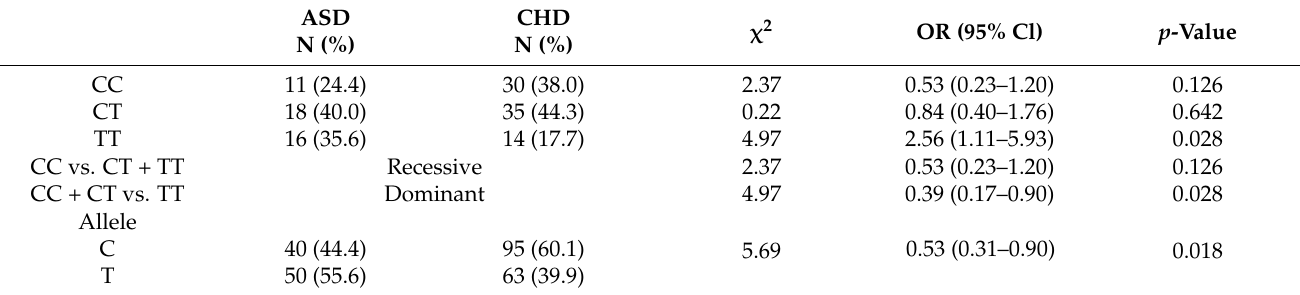
Table 4. Genotype and allele frequencies of DNMT3B rs2424913 gene polymorphism in Down syndrome individuals with atrial septal defects (ASDs) and other congenital heart defects